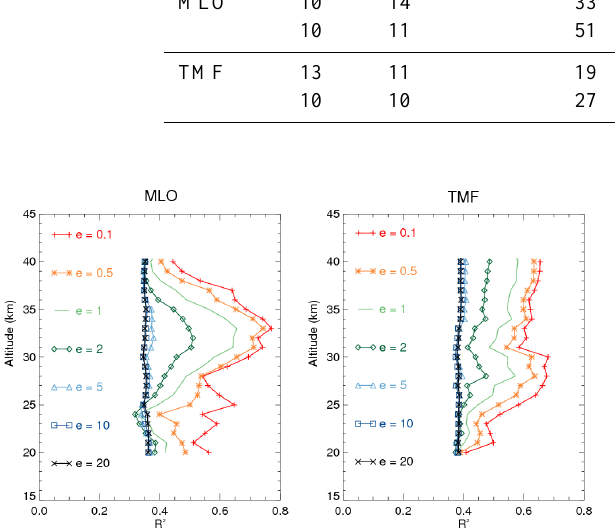
Fig. 5. Coefficient of determination R 2 values given by the noise sensitivity tests realized on the original signal with superimposed noise (see colored legend for values).